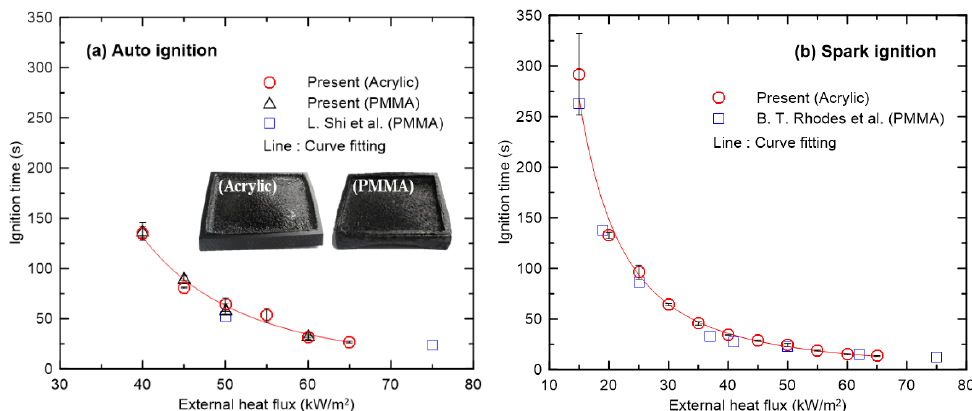
Figure 3. Ignition times as a function of external heat flux for the auto and spark ignitions.